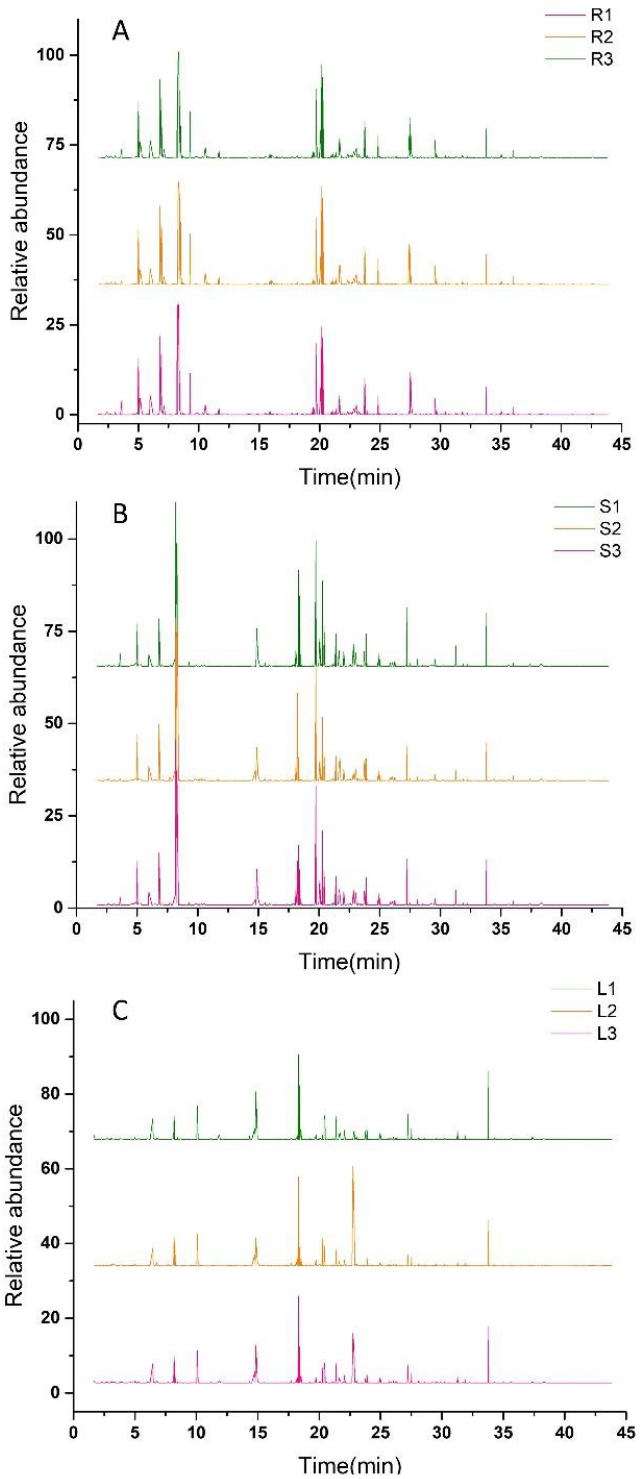
Figure 2. GC–MS chromatogram of Houttuynia cordata . ( A ) represents the total ion flow diagram of the Houttuynia cordata root; ( B ) represents the total ion flow diagram of the Houttuynia cordata stem; ( C ) represents the total ion flow diagram of the Houttuynia cordata leaf.